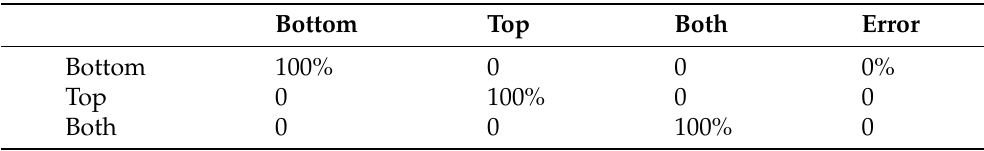
Table 8. Average confusion matrix using both the power signal and the acceleration signal for feature extraction.